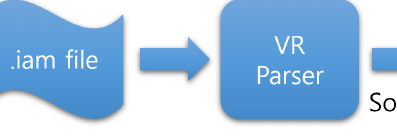
Figure 7. Smart connector